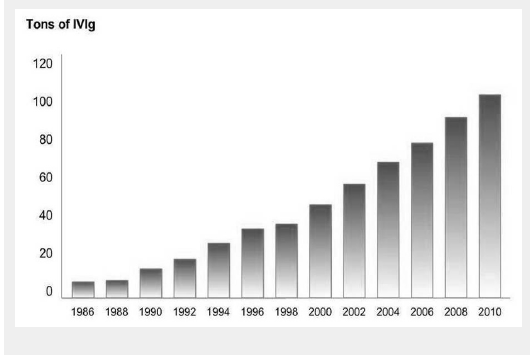
Total world consumption of IVIG: currently the IVIG production exceed 100 tonnes per year (published in International Blood/ Plasma News (ibpn), ©The Marketing Research Bureau Inc., Orange CT 40677 (mrb_ibpn@earthlink.net). Reprinted with kind